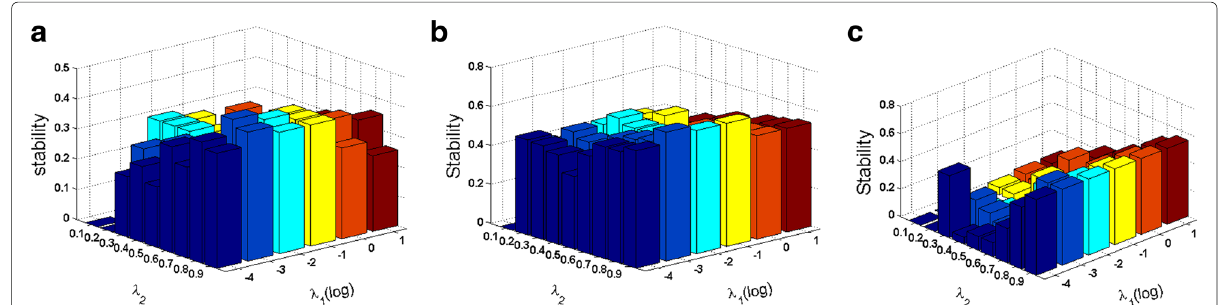
Fig. 5 Effects of λ 1 and λ 2 on stability for three specific classes. a “trees” in MIML. b “flowers” in NUS-WIDE-LITE. c “building” in